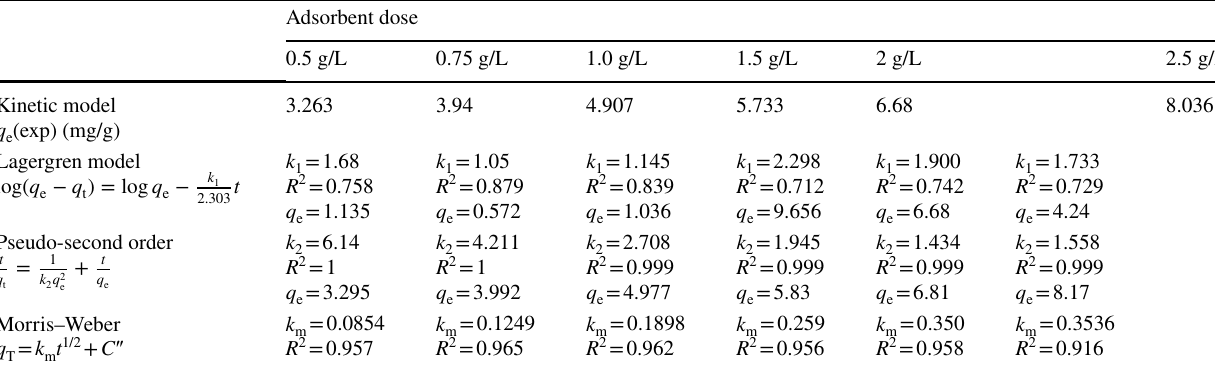
Table 3 Values of different parameters in kinetic model (varying adsorbent doses)